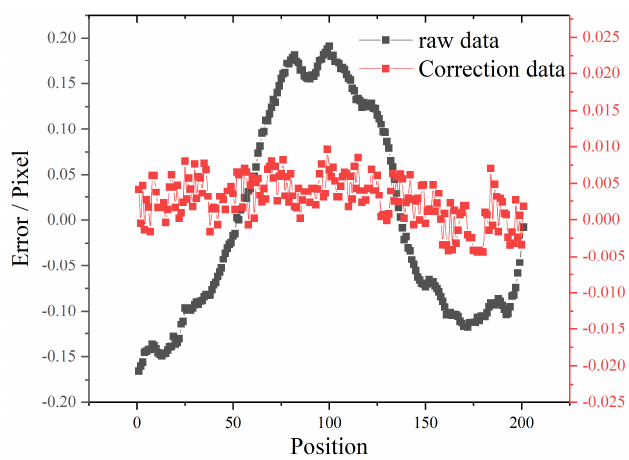
Figure 14. Corner points correction of image coordinate system.